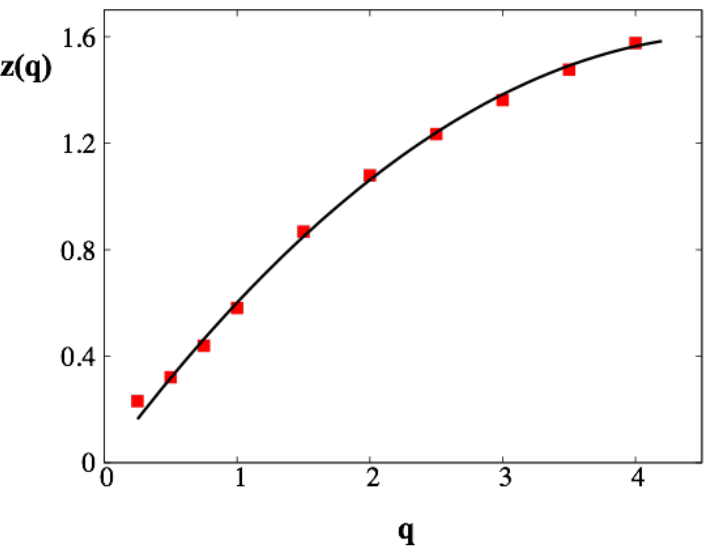
Figure 4. The structure function z ( q ) versus the order of the moment q for the temperature time series.